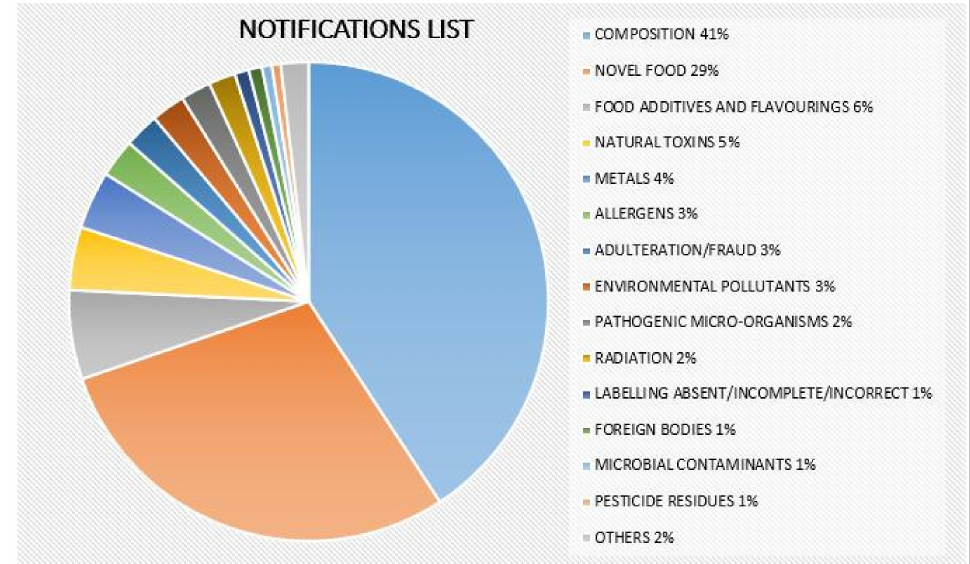
Figure 1. The range of RASFF notifications in the “dietetic foods, food supplements, fortified foods” category from January 2015 to February 2021.